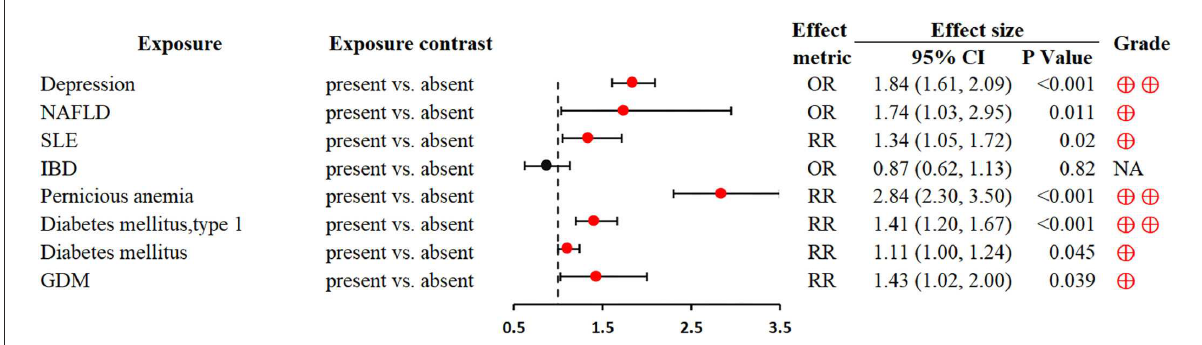
FIGURE7 Forest plot: summary effect estimates of meta-analyses reporting associations between GC and factors pertaining to pre-existing medical history. NAFLD, non-alcoholic fatty liver disease; SLE, systemic lupus erythematosus; IBD, inflammatory bowel disease; GDM, gestational diabetes mellitus.